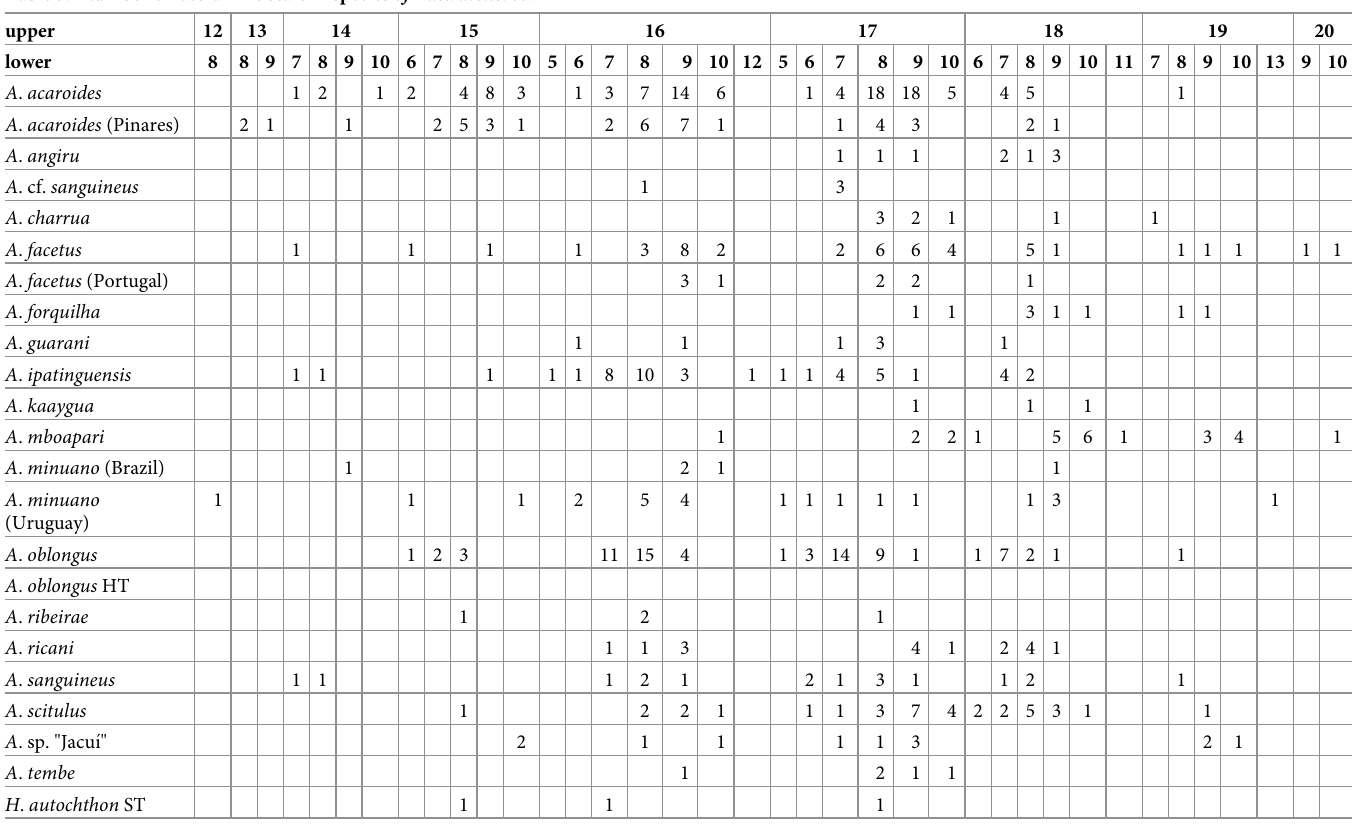
Table 5. Number of lateral line scale in species of Australoheros